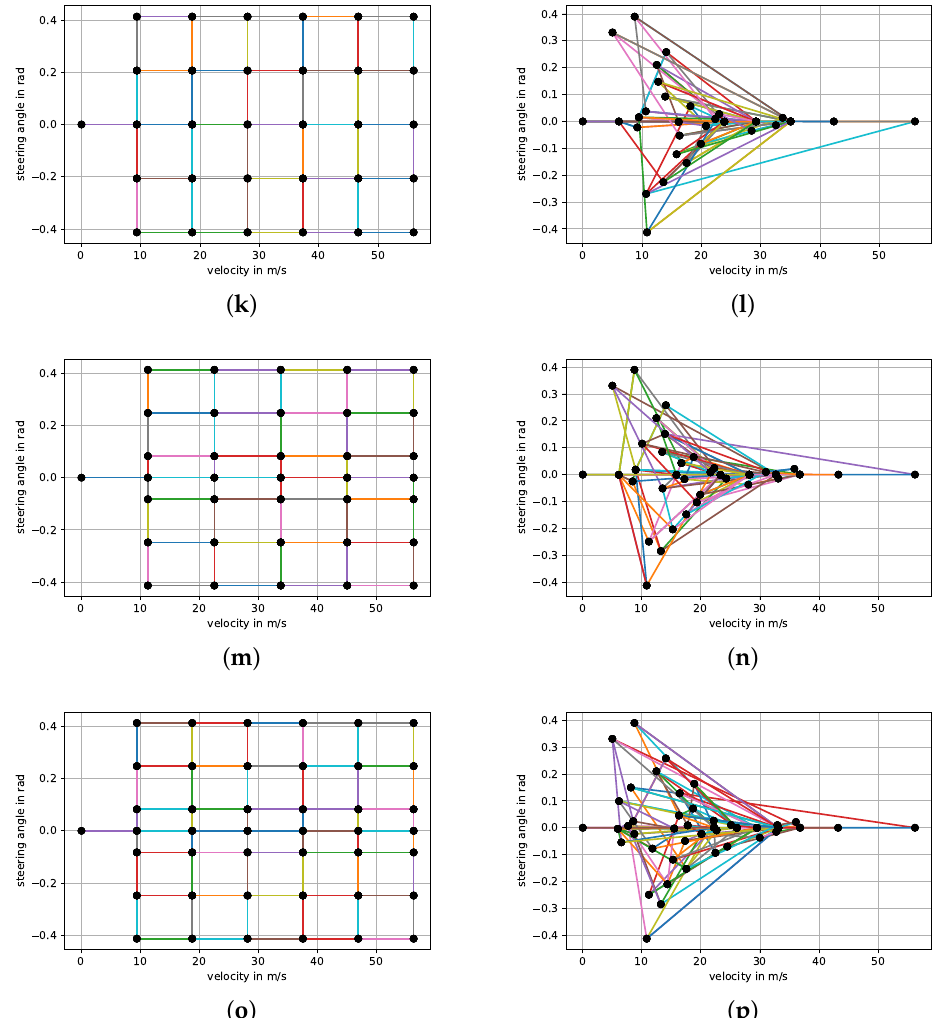
Figure 8. Automata with different sizes. With 4 trims: ( a ) handcrafted; ( b ) extracted; with 7 trims: ( c ) handcrafted; ( d ) extracted; with 13 trims: ( e ) handcrafted; ( f ) extracted; with 21 trims: ( g ) hand- crafted; ( h ) extracted; with 26 trims: ( i ) handcrafted; ( j ) extracted; with 31 trims: ( k ) handcrafted; ( l ) extracted; with 36 trims: ( m ) handcrafted; ( n ) extracted; and with 43 trims: ( o ) handcrafted; ( p ) extracted. The handcrafted automata are based on the considered model only and the extracted automata are based on data and model. Different colors only highlight distinct relationships be- tween